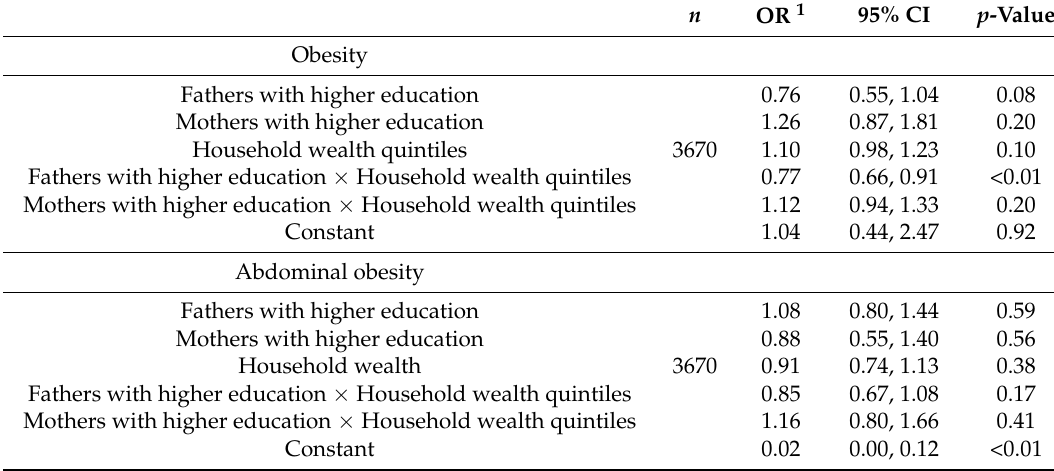
Table 5. Interaction between parents’ education and household wealth quintiles on obesity and abdominal obesity